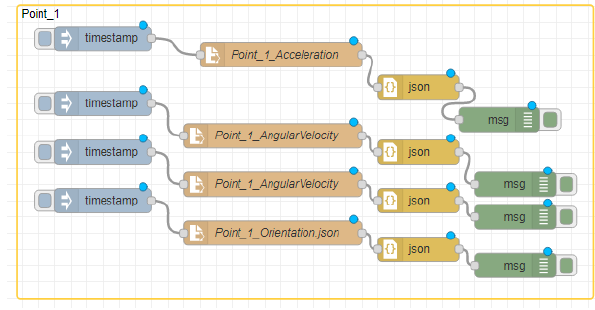
Figure 66. Start point acceleration sensor.